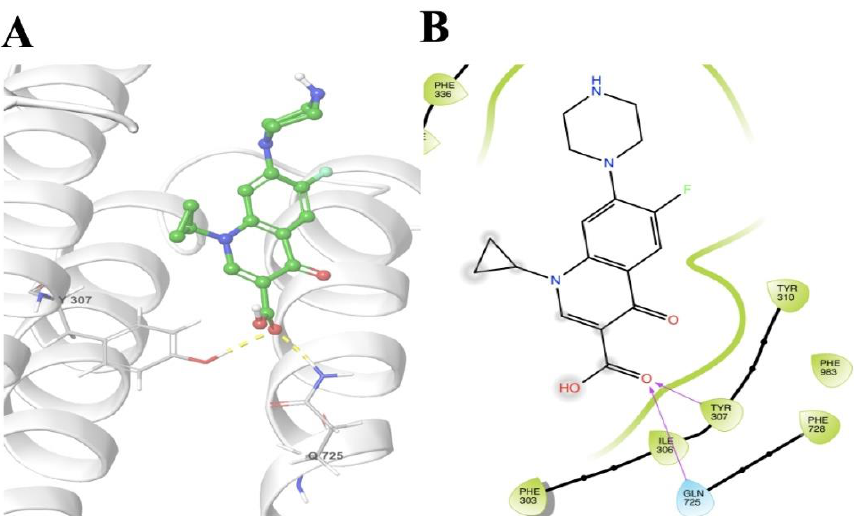
Figure 6. Molecular interaction of ciprofloxacin with the human homology ABCB1. Extra precision docking model of ciprofloxacin within transmembrane domains of homology modeled human ABCB1. ( A ) Docking pose of ciprofloxacin. Amino acid residues are illustrated as thin tubes with the color representations as follows: carbon in gray, hydrogen in white, nitrogen in blue, oxygen in red, and sulfur in yellow. The protein is represented in white colored ribbon form. The inhibitor is represented by the ball and stick model with identical colors as above except that carbon atoms are represented in green. Blue dashes represent the π - π stacking interaction, yellow dashes represent the hydrogen bonding and the salt bridge is indicated by purple dashes. ( B ) 2-D representation of docking pose of ciprofloxacin. The colored drops (green indicate hydrophobic) indicate amino acid residues within 5 Å of the ligand and the arrows (magenta) show hydrogen bonds.